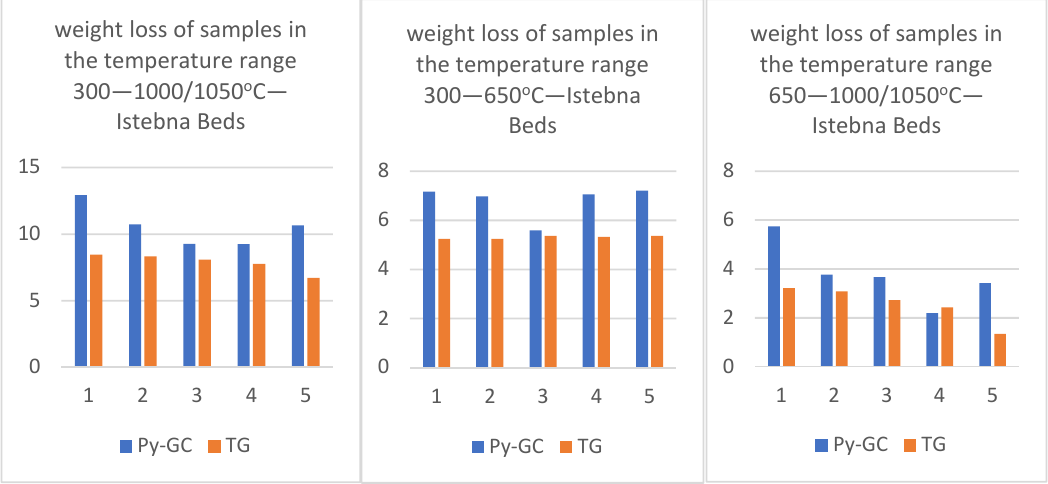
Figure 8. Comparison of the weight loss of samples (%) from the Istebna Beds during Py/GC and TG/DSC pyrolysis in total and over two temperature ranges.